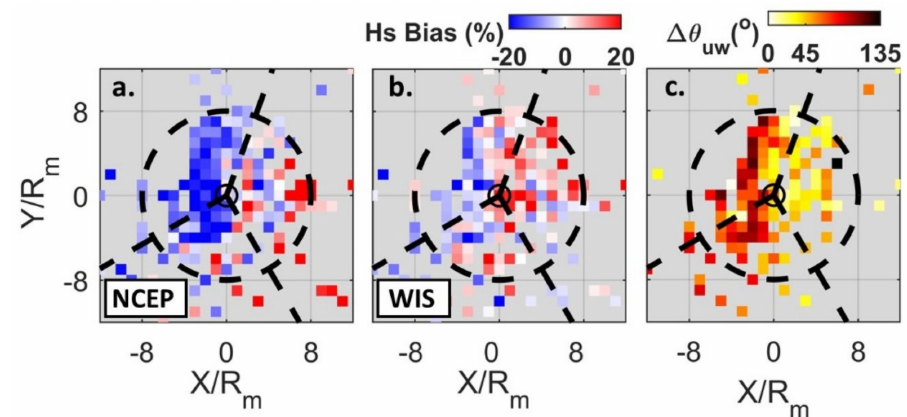
Figure 7. Hs bias at all buoy locations during Hurricane Sandy for ( a ) NCEP and ( b ) WIS in a storm-centric frame of reference with distance from the eye normalized by the radius of maximum winds (Rm). ( c ) Difference between dominant wave direction and wind direction ( θ uw ). Observations were binned into 1 Rm × 1 Rm bins. The inner circle denotes 1 Rm and outer dotted circle denotes 8 Rm. Direction of storm motion is up the